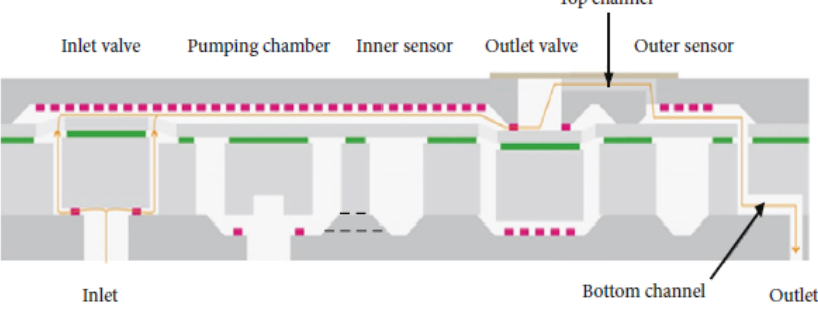
Figure 15. The cross-sectional scheme of the micropump proposed in Reference [22] (Reproduced under Creative Commons Attribution License).